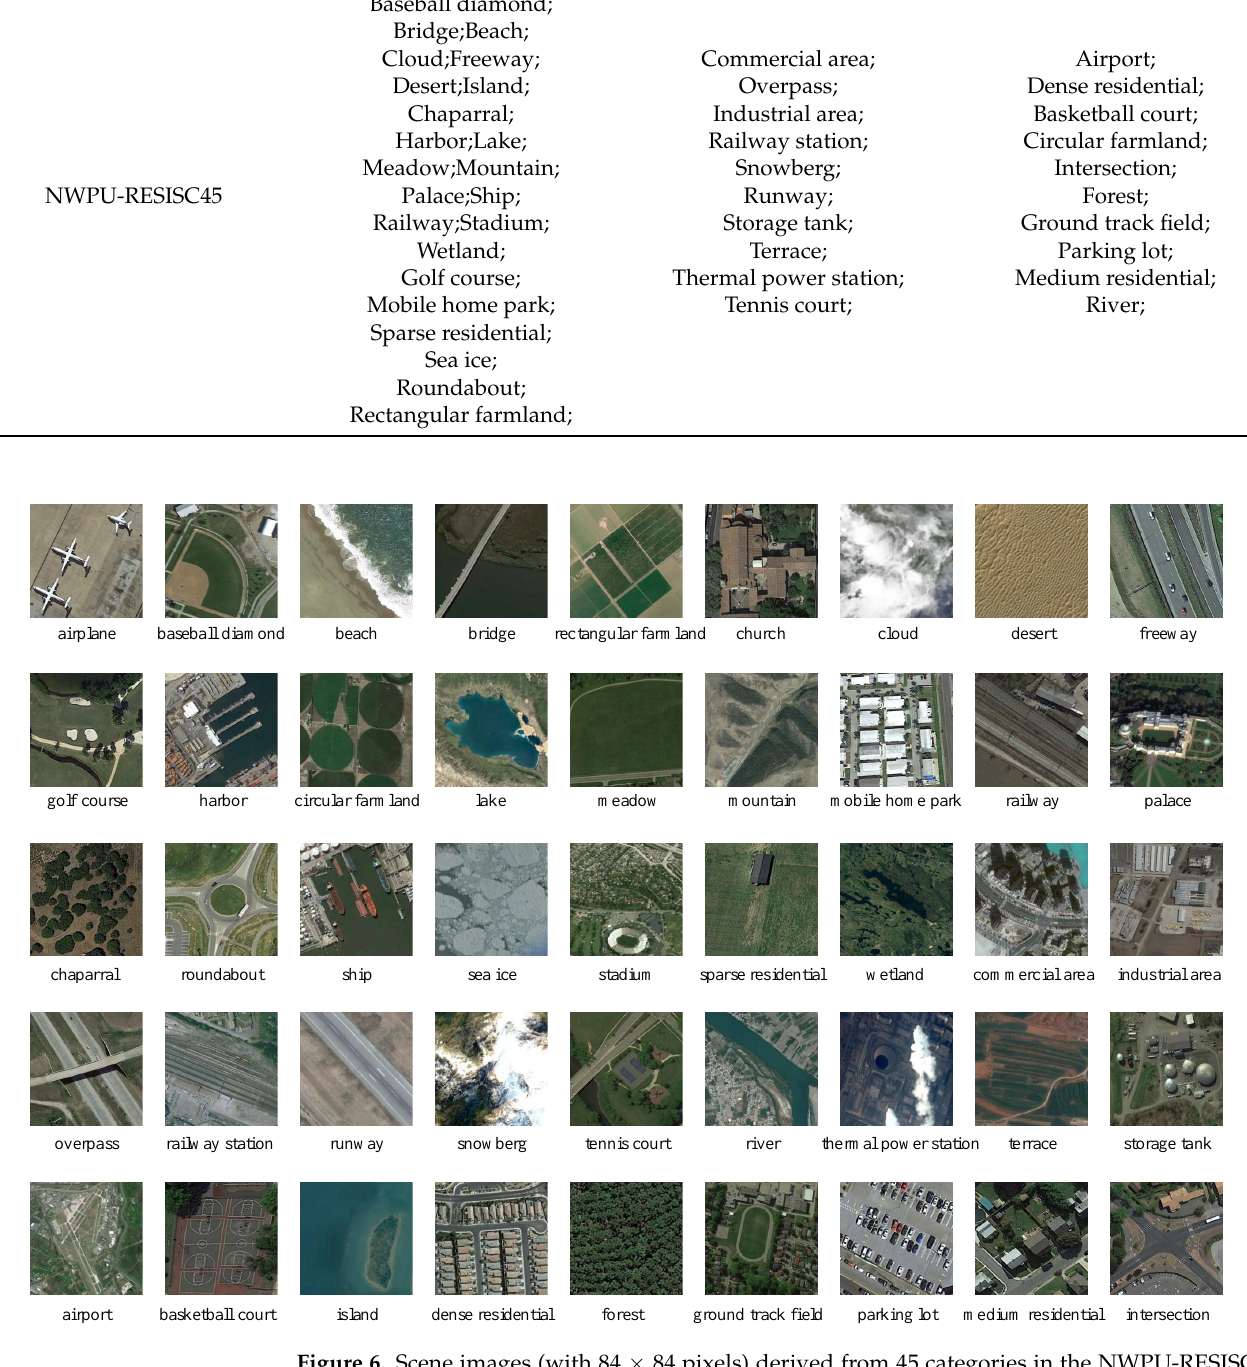
Figure 6. Scene images (with 84 × 84 pixels) derived from 45 categories in the NWPU-RESISC45 dataset [61]. Airport, basketball court, circular farmland, dense residential, forest, ground track field, intersection, medium residential, Parking lot, and river are selected as the novel set for perfor- mance